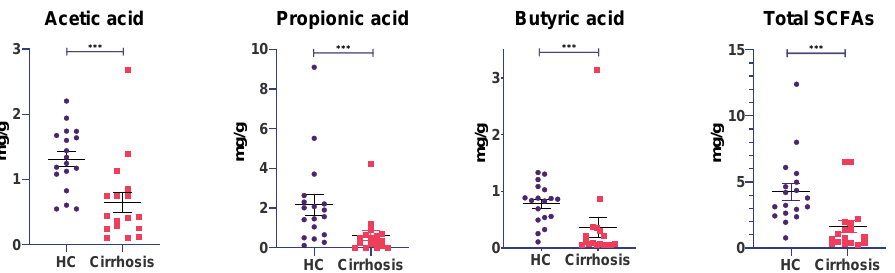
Figure 4. PICRUSt2 functional prediction of the patients with cirrhosis (red) compared with healthy controls (HC, purple). ( A ) Comparisons among MetaCyc pathways shown by mean proportion and difference in mean proportions; ( B ) Most relevant pathways are shown individually. The analysis was done with Welch’s inverted method, p -values were filtered with a cut-off value of p < 0.05.